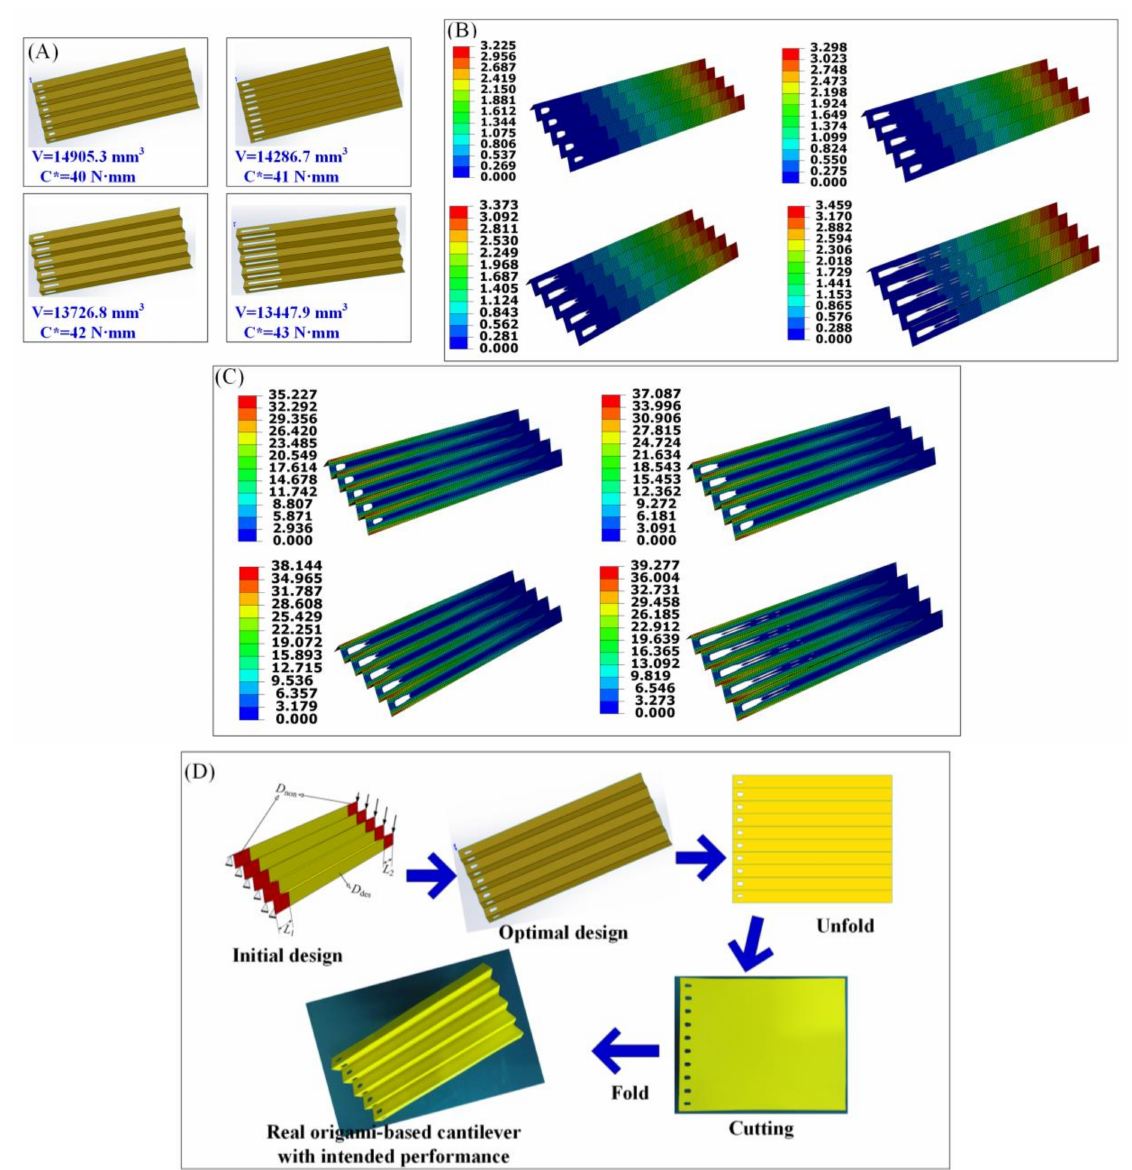
Figure 3. ( A ) Optimal designs for the origami-based cantilever under various constraints; ( B ) the corresponding displacements of the optimal solutions (unit: mm); ( C ) the corresponding stress distributions of the optimal solutions (unit: MPa); and ( D ) applying the proposed framework to the origami-based